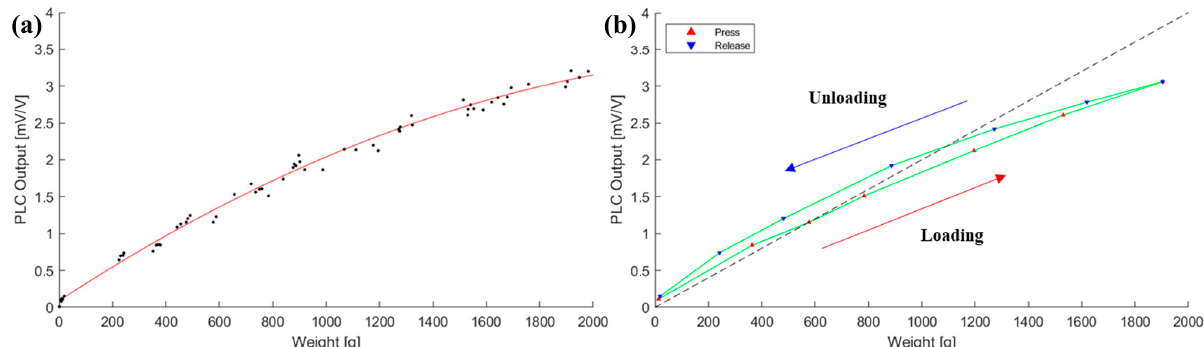
Figure 10. Loading/unloading test of the PLC to the maximum analytical load, 2 kg: ( a ) hysteresis characteristic; and ( b ) 5 time measurements.